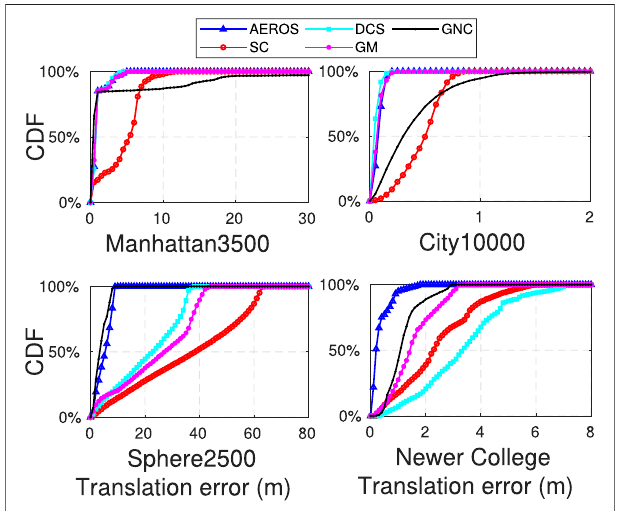
FIGURE 7 | Cumulative distribution of errors for the experiments described in Sec. 4 .